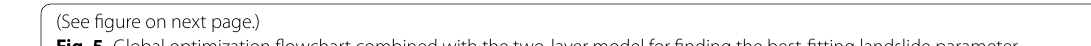
parameter(See figure on next Fig. 5 Global optimization flowchart combined with the two-layer model for finding the best-fitting landslide